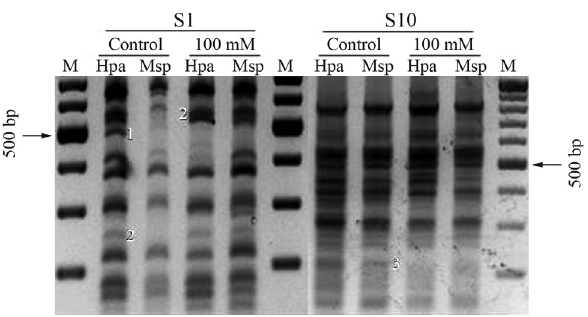
Figure 3 - CRED-RA results of primers S1 and S10 in 100 mM NaCl- -treated plants and controls. Polymorphic bands are indicated with num- bers. Detailed interpretation can be found in the